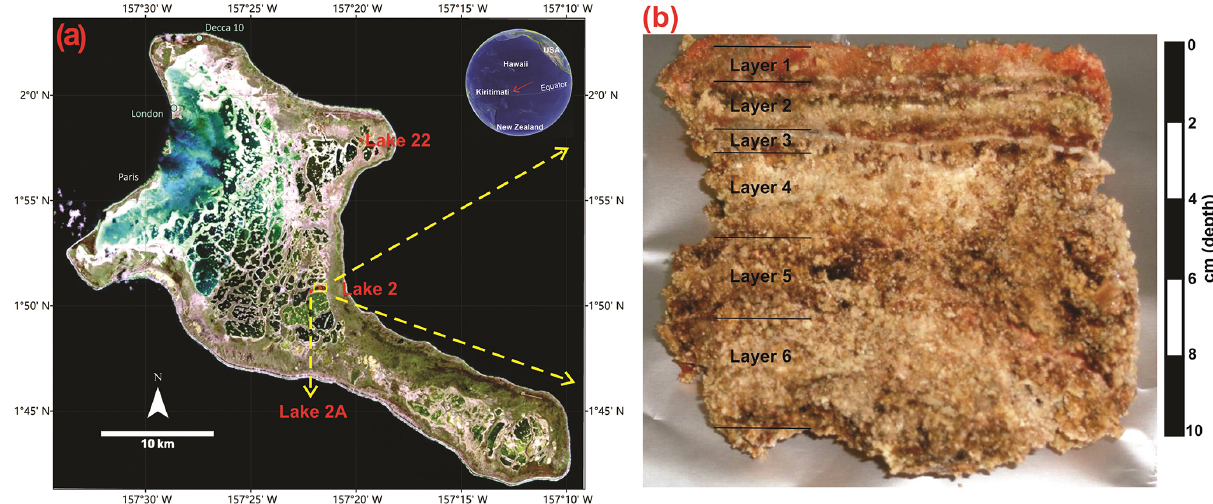
Figure 1. (a) Location of Kiritimati atoll in the Pacific Ocean and satellite view (Landsat 7 image, 1999) showing reticulate distribution pattern of the lakes (red dots: Lake 2 studied in this work; Lake 2A and 22 previously studied by Bühring et al., 2009, and Shen et al., 2018a); (b) the microbial mat sample from Lake 2 studied in this